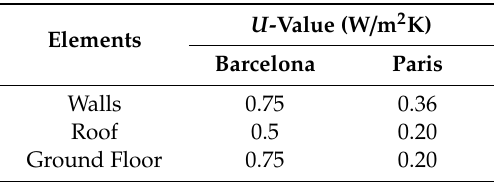
Table 7. Envelope thermal